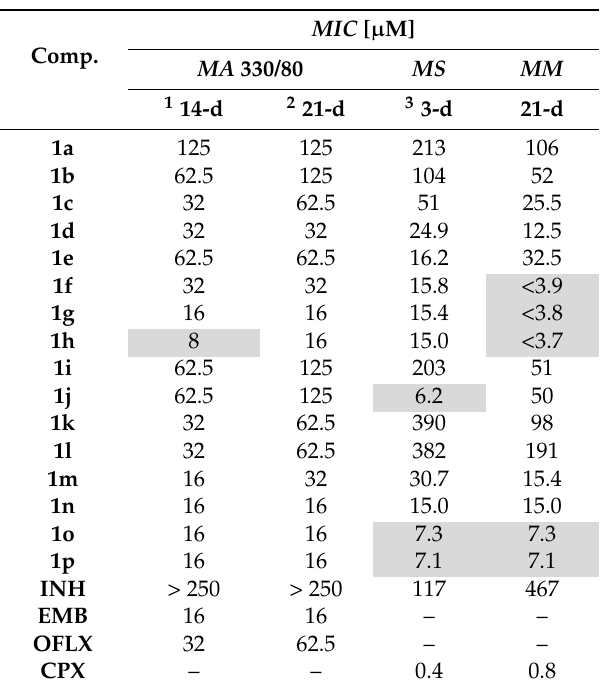
Table 7. The in vitro activity ( MIC values in μ M units) of investigated compounds 1a – p and reference drugs isoniazid (INH), ethambutol (EMB), ofloxacin (OFLX) and ciprofloxacin (CPX) against M. avium CNCTC My 330/80 ( MA 330/80), M. smegmatis ATCC 700084 ( MS ) and M. marinum CAMP 5644 ( MM ), respectively.